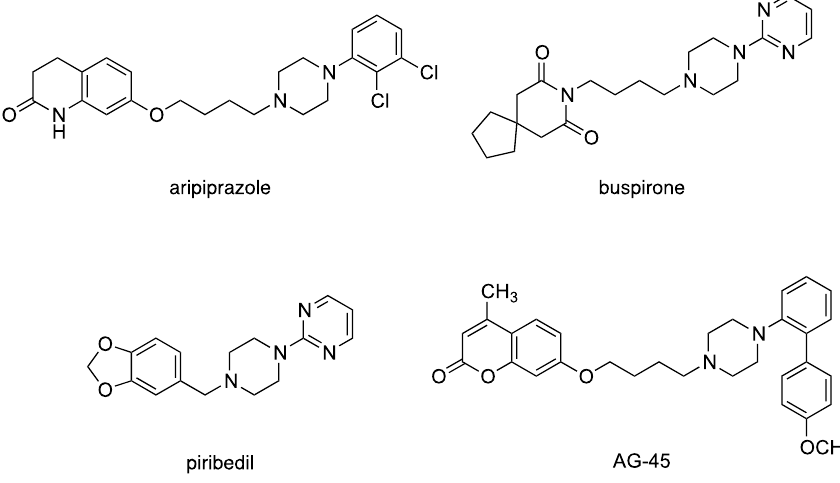
Figure 1. Representative arylpiperazine derivatives.